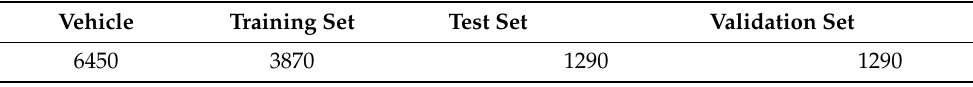
Table 2. Vehicle target detection